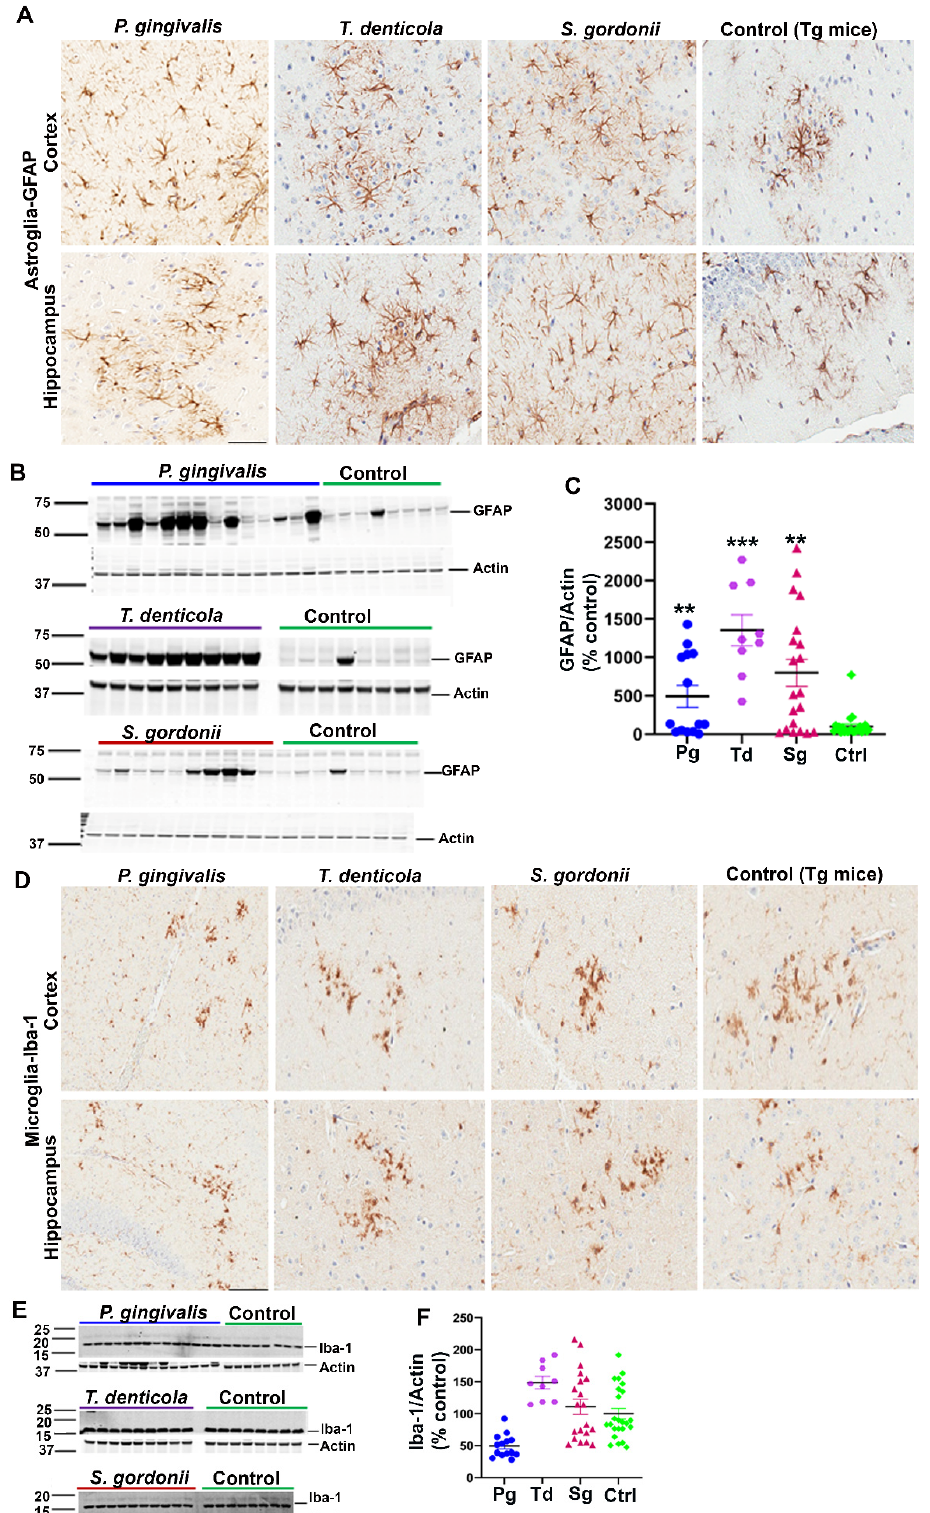
Figure 2. Gingival infection significantly induced astrogliosis but did not alter microgliosis in Tg mice. ( A ) Representative brain sections of the Tg mice infected with P. gingivalis , T. denticola , S. gordonii, and sham-infected Tg mice were immunostained for astroglial marker GFAP in the cortex and